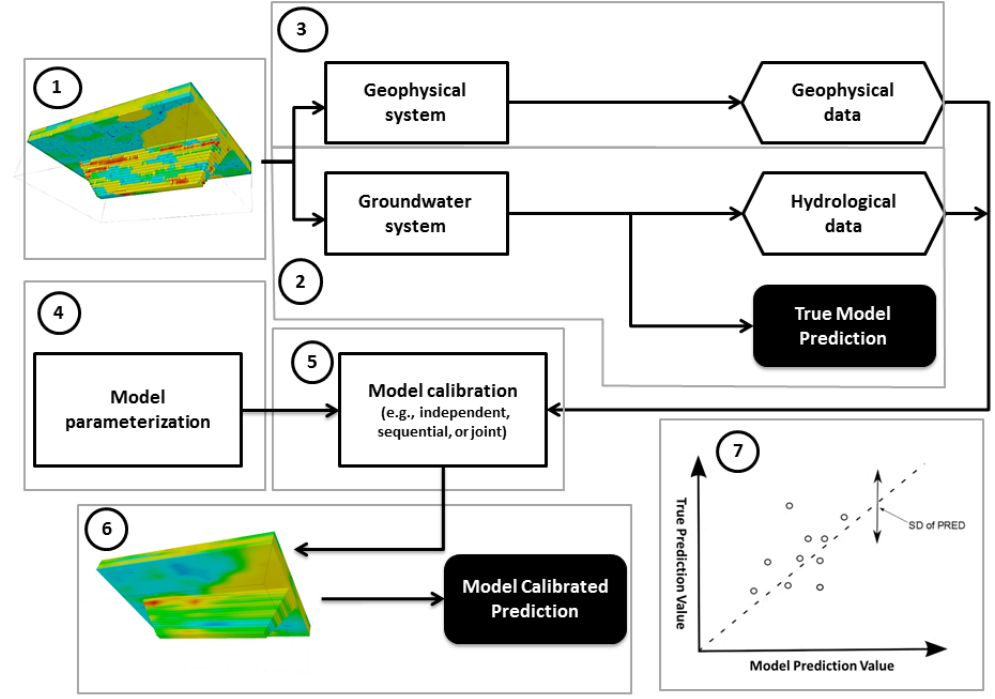
Figure 1. Workflow of the HYTEB. Each numbered dashed box marks a major step in the workflow. In parts 1 and 5 the red, yellow, blue and green colors indicate different categories (types) of geological deposits; color variation within each category (in part 6) indicates variation in hydraulic